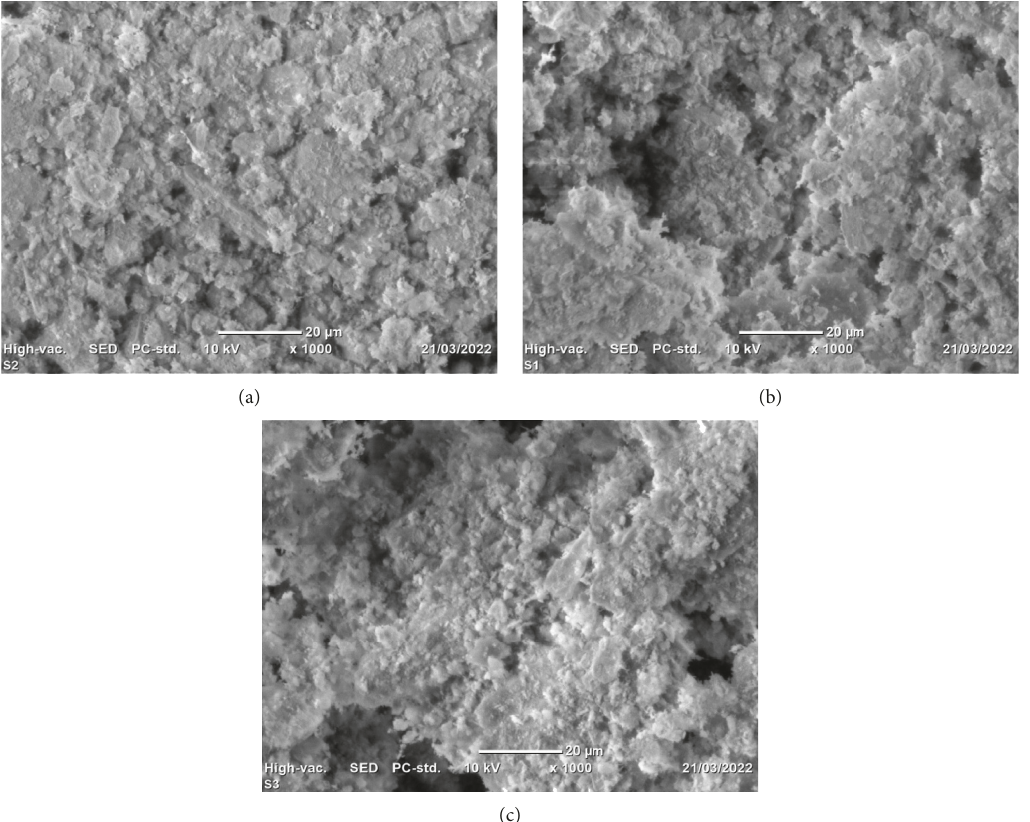
Figure 7: SEM results at 10kV and 20 μ m for (a) kaolinite, (b) metakaolinite, and (c) residue after leaching at 0.10g · mL − 1 , 5M, 80 ° C, and